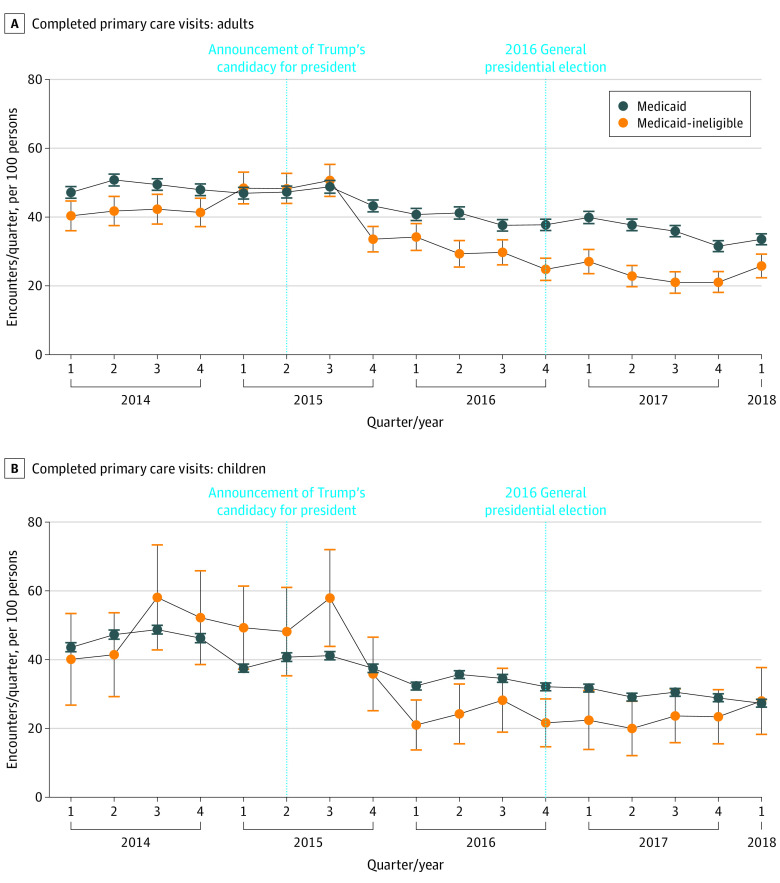
Adjusted Mean Number of Completed Primary Care Quarterly VisitsCompleted primary care visits for adults (A) and children (B). Error bars show 95% CIs.